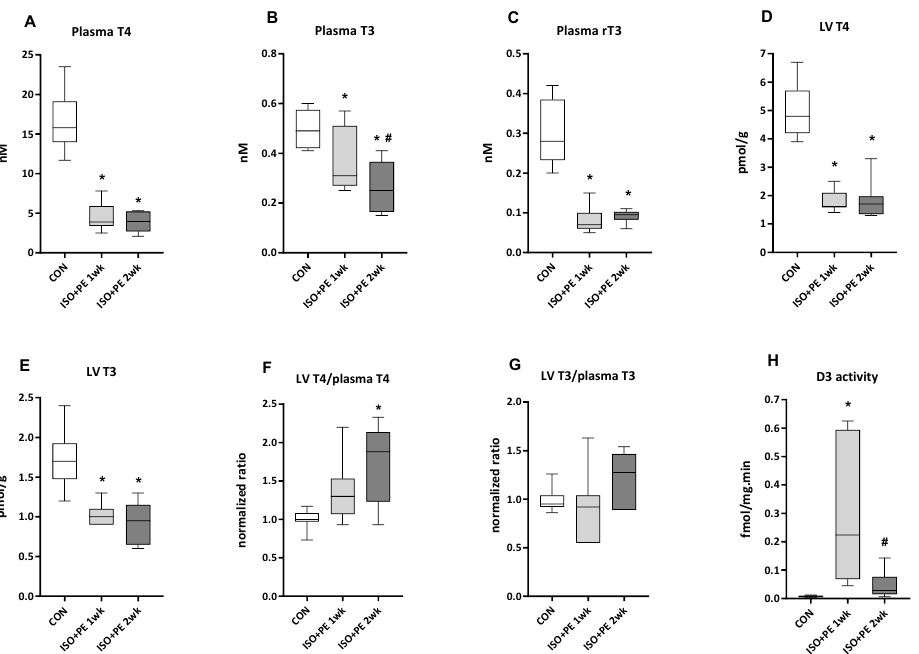
Figure 4. The effect of one and two weeks of ISO + PE infusion on plasma and LV thyroid hormone Figure 4 . The effect of one and two weeks of ISO + PE infusion on plasma and LV thyroid hormone levels and LV D3 activity. Plasma concentrations ( A – C ) of T4, T3 and rT3 and ( C , D ) LV tissue content levels and LV D3 activity. Plasma concentrations ( A – C ) of T4, T3 and rT3 and ( C , D ) LV tissue con- of T4 and T3 were determined by tandem mass spectrometry. Tissue/plasma ratios ( F , G ) were tent of T4 and T3 were determined by tandem mass spectrometry. Tissue/plasma ratios ( F , G ) were normalized to the respective mean control value. LV D3 activity ( H ) was determined in tissue normalized to the respective mean control value. LV D3 activity ( H ) was determined in tissue ho- mogenates by conversion of radiolabeled T3 followed by HPLC and quantification of T2. Data are homogenates by conversion of radiolabeled T3 followed by HPLC and quantification of T2. Data Figure 4 . The effect of one and two weeks of ISO + PE infusion on plasma and LV thyroid hormone presented as median and quartiles with whiskers indicating minimum and maximum values. ( A – are presented as median and quartiles with whiskers indicating minimum and maximum values. levels and LV D3 activity. Plasma concentrations ( A – C ) of T4, T3 and rT3 and ( C , D ) LV tissue con- G ): n = 6 – 10 for all groups; ( H ): CON: n = 5; ISO + PE 1 wk: n = 7; ISO + PE 2 wk: n = 8. Two-way ( A – G ): n = 6–10 for all groups; ( H ): CON: n = 5; ISO + PE 1 week: n = 7; ISO + PE 2 week: n = 8. tent of T4 and T3 were determined by tandem mass spectrometry. Tissue/plasma ratios ( F , G ) were ANOVA followed by unprotected Fisher’s LSD test was used to determine significance of differ- Two-way ANOVA followed by unprotected Fisher’s LSD test was used to determine significance of normalized to the respective mean control value. LV D3 activity ( H ) was determined in tissue ho- ences. *: p < 0.05 vs. CON, #: p < 0.05 vs. 1 wk. differences. *: p < 0.05 vs. CON, #: p < 0.05 vs. 1 week. mogenates by conversion of radiolabeled T3 followed by HPLC and quantification of T2. Data are presented as median and quartiles with whiskers indicating minimum and maximum values. ( A – The possible relevance of cardiac thyroid hormone levels for LV function is indicated LV D3 activity most likely played a role in the low LV T3 levels as it was strongly G ): n = 6 – 10 for all groups; ( H ): CON: n = 5; ISO + PE 1 wk: n = 7; ISO + PE 2 wk: n = 8. Two-way by the positive correlation of these levels and the ejection fraction (Figure 5A,B). induced at week one (Figure 4H), with the highest absolute activities similar to those previ- ANOVA followed by unprotected Fisher’s LSD test was used to determine significance of differ- ously reported for other models of pathological ventricular hypertrophy (see Discussion). ences. *: p < 0.05 vs. CON, #: p < 0.05 vs. 1 wk. Surprisingly, D3 activity returned to levels not significantly different from controls after The possible relevance of cardiac thyroid hormone levels for LV function is indicated two weeks. by the positive correlation of these levels and the ejection fraction (Figure 5A,B). The possible relevance of cardiac thyroid hormone levels for LV function is indicated by the positive correlation of these levels and the ejection fraction (Figure 5A,B).